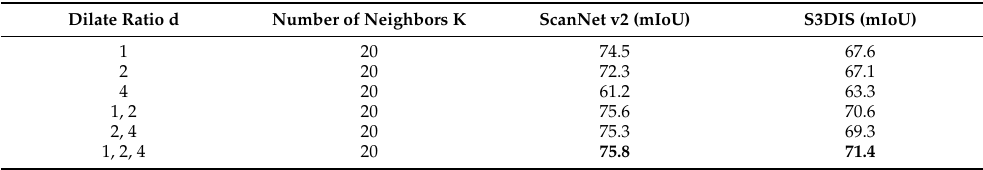
Figure 9. Experiment conducted with varying values of the threshold parameter µ on the valida- tion set. Table 12. Ablation studies on the proposed DFA module. The bold denotes the best performance.